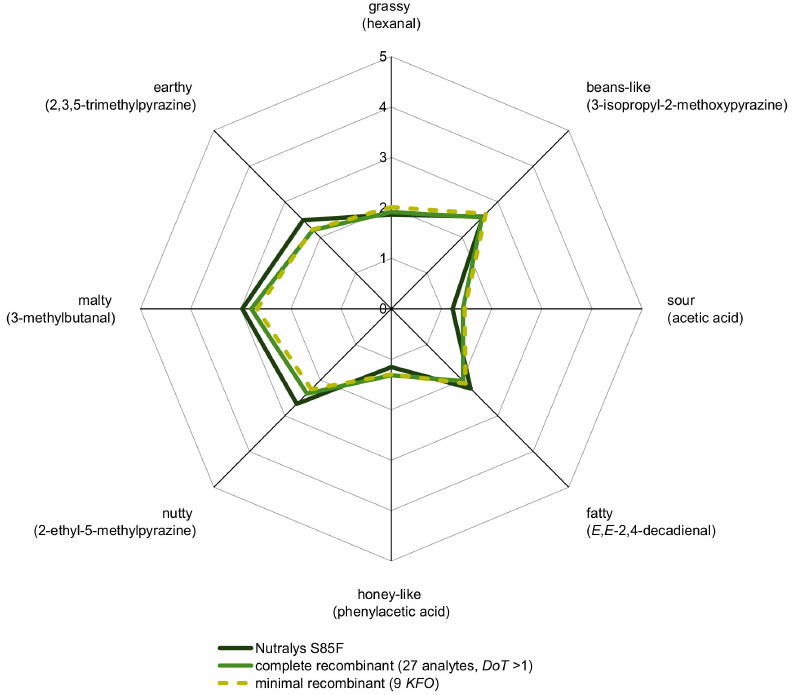
Figure 4. Aroma profile analysis of 10% C in water/triacetin (97.5:2.5, w / w ) and its complete as well as minimal recombinant (10% deodorized protein in water/triacetin, 97.5:2.5, w / w ). Odorants specified in brackets were used as reference attributes for the corresponding odor quality and perceived intensities were rated from 0 (not detectable) to 5 (very intense) by the